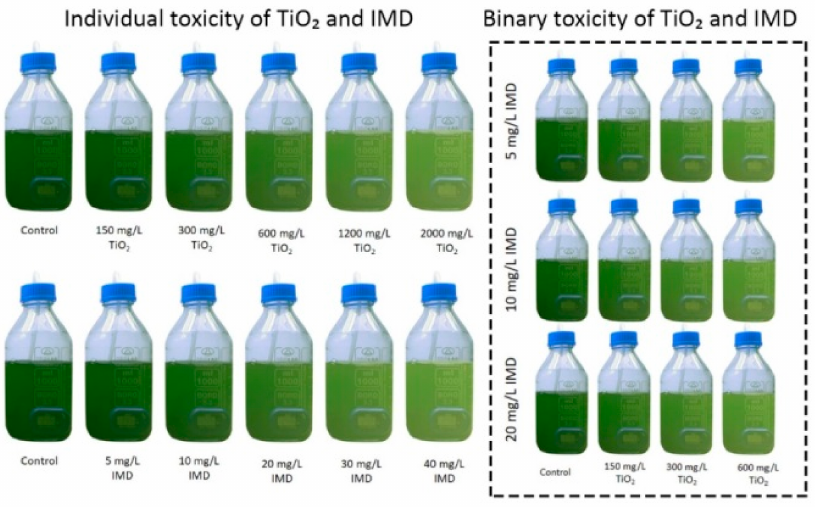
Figure 1. The experimental description of individual and binary toxicity of TiO 2 nanoparticles and IMD